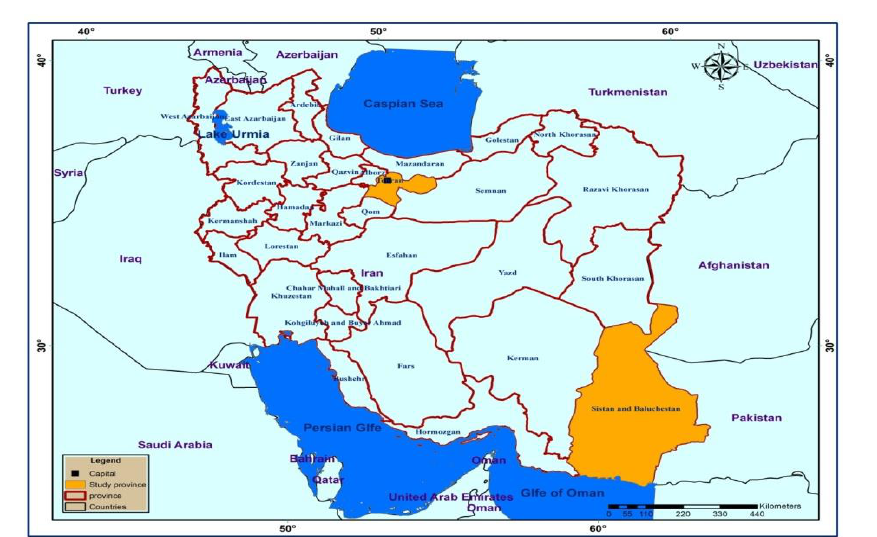
Figure 2: Iran' provinces and Geographical location of Tehran and Sistan & Baluchestan Source: Authors, 2021